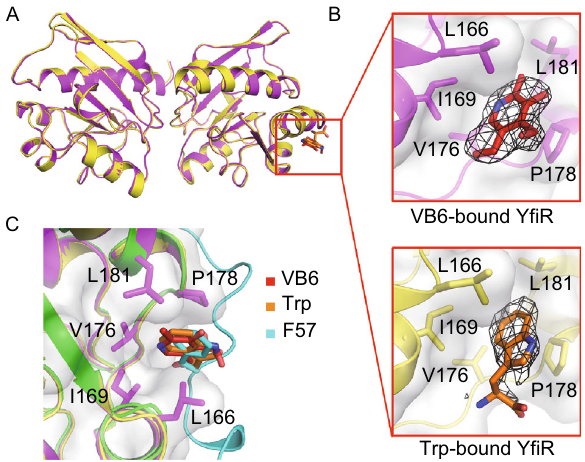
Figure 5. Overall Structures of VB6-bound and Trp-bound Y fi R. (A) Superposition of the overall structures of VB6-bound and Trp-bound Y fi R. (B) Close-up views showing the key residues of Y fi R that bind VB6 and L-Trp. The electron densities of VB6 and Trp are countered at 3.0 σ and 2.3 σ , respectively, in | F o|-| F c| maps. (C) Superposition of the hydrophobic pocket of Y fi R with VB6, L-Trp and F57 of Y fi